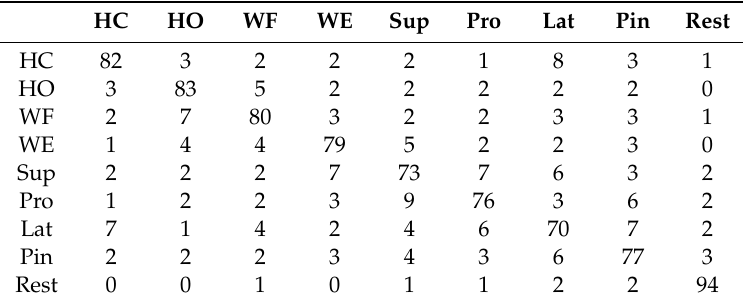
Table 4. Confusion matrix based on within-session calibration (the mean across the two days have been calculated) using autoencoders. All values are in percent and presented as the mean across participants. HC (Hand Close), HO (Hand Open), WE (Wrist Extension), WF (Wrist Flexion), Sup (Supination), Pro (Pronation), Lat (Lateral Grasp), and Pin (Pinch Grasp).